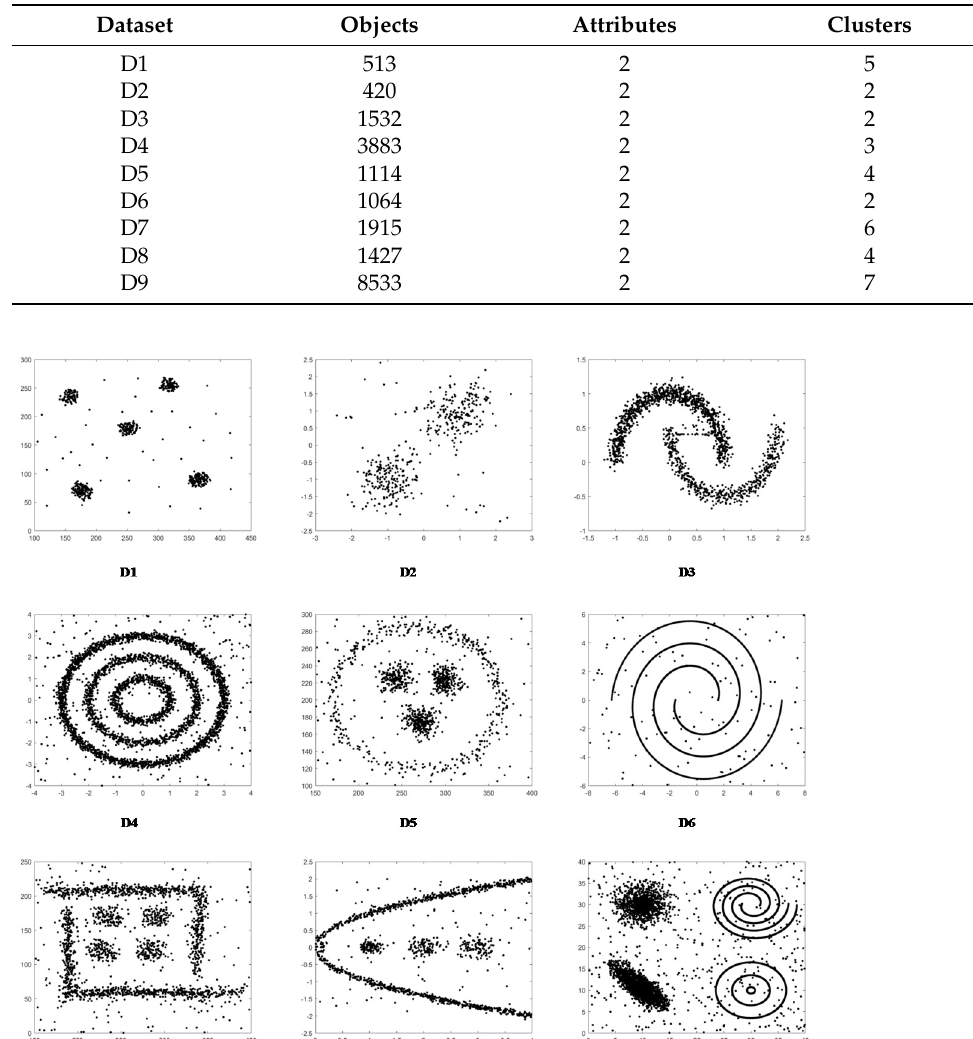
Figure 6. The results of 9 clustering algorithms in D1.